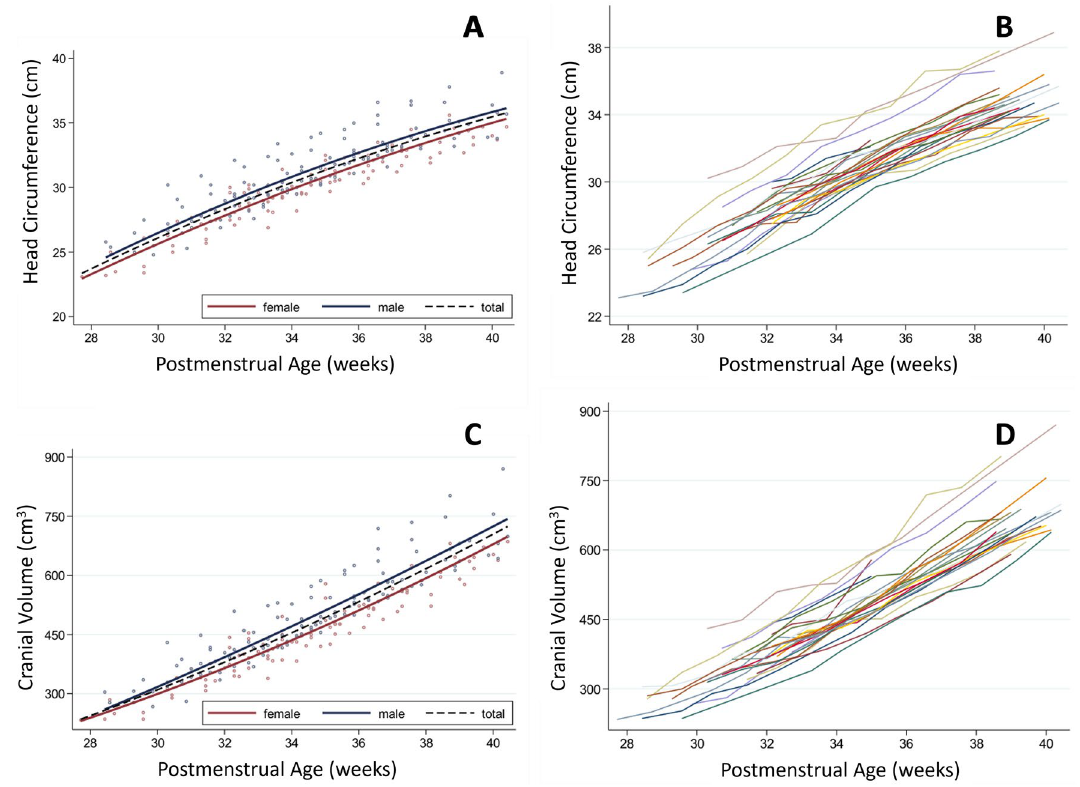
Figure 2. Longitudinal development of head circumference ( A,B ) and cranial volume ( C,D ). Scatter plots of all measurements (n = 217 ( A,C )) with 2nd degree polynomial regression for all, female and male infants, and individual cranial index graphs ( B,D